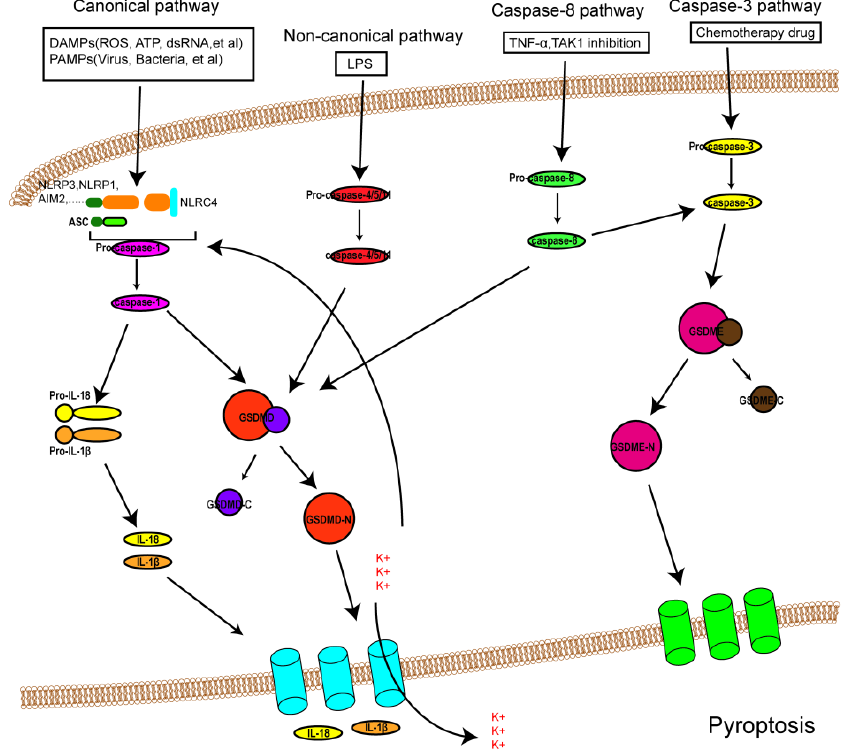
Figure 1. An overview of the mechanisms of pyroptosis. In the canonical pathway, PAMPs and DAMPs receive signaling molecule stimulation and assemble with pro-caspase-1 and ASC to form inflammasomes and active caspase-1. Activated caspase-1 cleaves GSDMD into GSDMD-N and GDSMD-C and lyses the precursors of IL-1 β and IL-18 (pro-IL β and pro-IL-18, respectively). GSDMD-N perforates the cell membrane by forming non-selective pores, further causing water influx and cell swelling and bursting. In addition, IL-1 β and IL-18 are secreted from the pores formed by GSDMD-N. In the noncanonical pathway, LPS activates caspase-4/5 and caspase-11, triggering pyroptosis by cleaving GSDMD. In addition, the cleavage of GSDMD results in efflux of K+, ultimately giving rise to the assembly of an NLRP3 inflammasome. In the caspase-3-mediated pathway, active caspase-3 cleaves GSDME to form GSDME-N, inducing cell pyroptosis. In the caspase-8-me- diated pathway, inhibiting TAK1 induces the activation of caspase-8, which cleaves GSDMD or GSDME and results in pyroptosis.